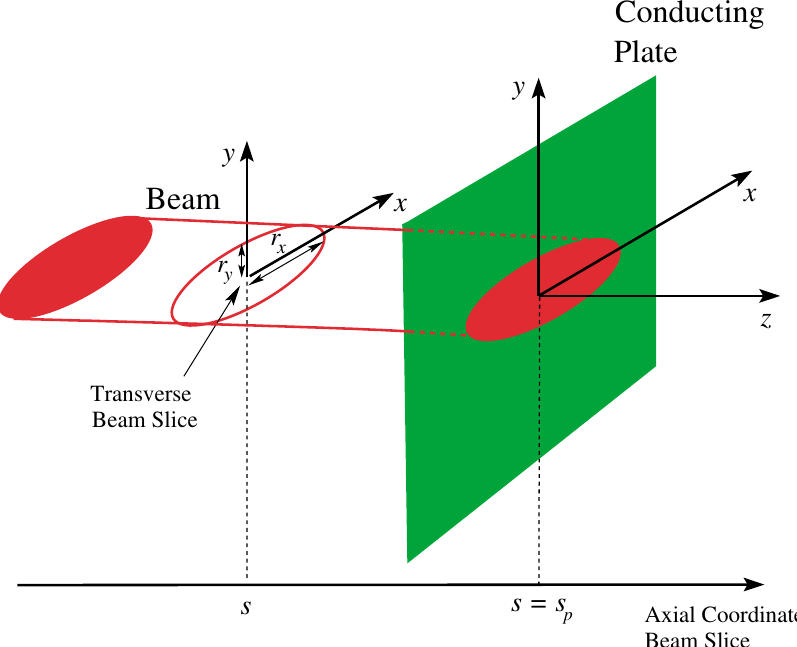
FIG. 2. (Color) Geometry of an unbunched beam incident on a conducting plane from the left ( z < 0